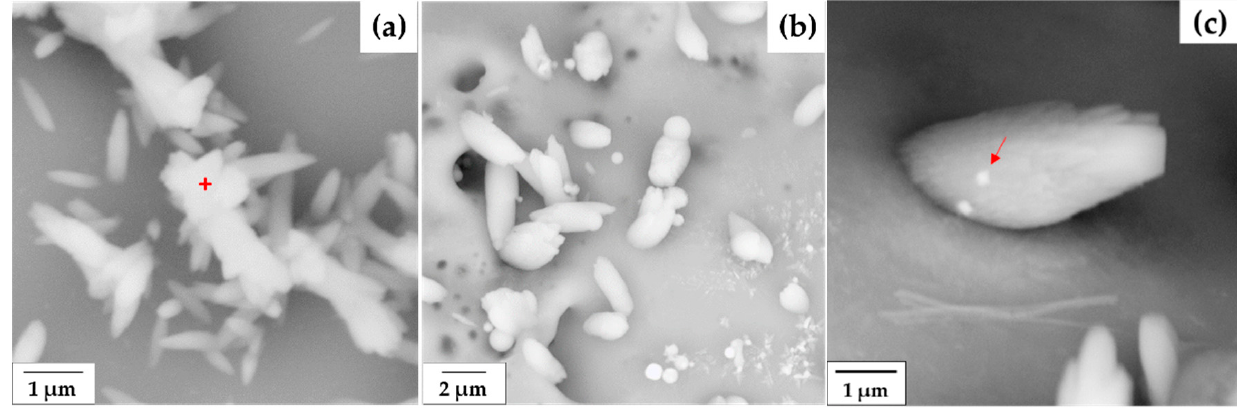
Figure 3. ( a ) Needle-like structure forming on the surface of the cenosphere obtained from using the centrifugal speed of 4000 rpm at 10 min. ( b ) Crystal growth observed for the ash soaking time at 48 h. ( c ) The arrow shows the iron particles attached to the crystal.